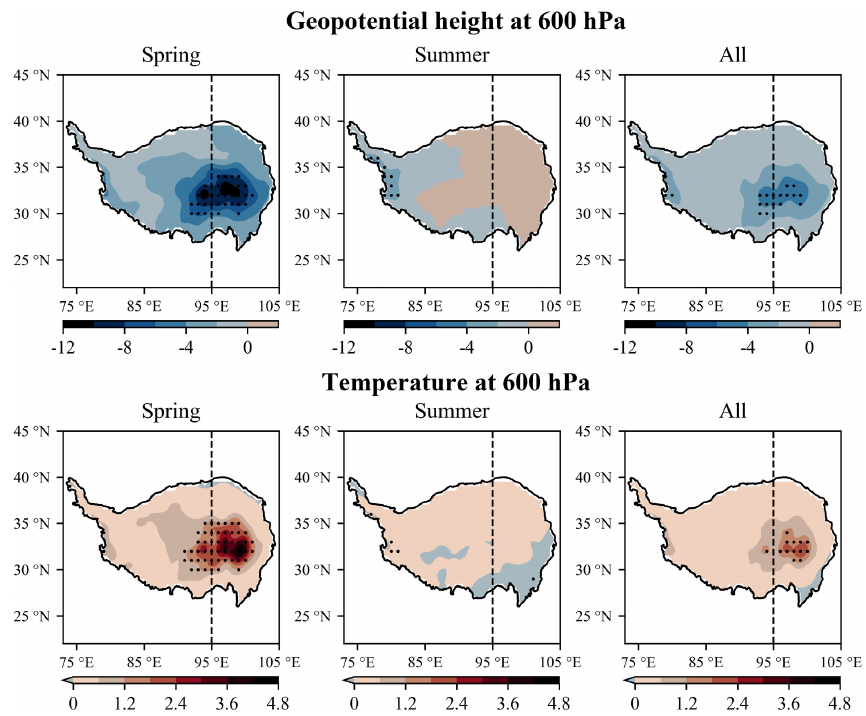
Figure 10. The spatial differences in geopotential height (geopotential metres – gpm) and temperature ( ◦ C) at 600hPa between the two en- semble reforecasts (the DA reforecasts minus the control reforecasts). The stippled regions show the statistical significance of the differences identified by the t test at a 5% significance